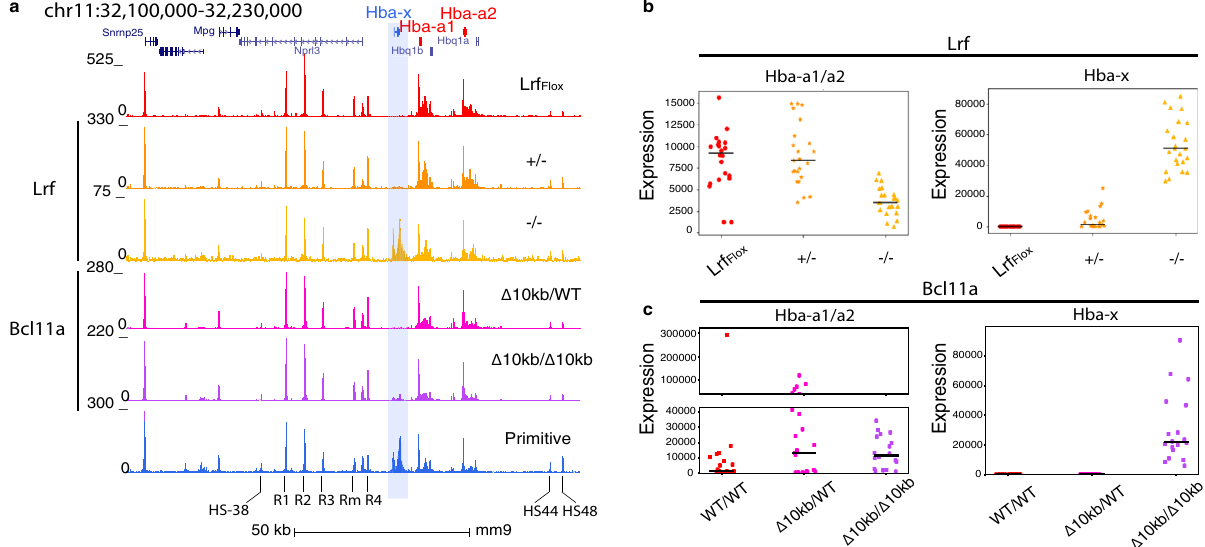
Fig. 6 Lrf and Bcl11a play a role in silencing ζ -globin expression in mice. a ATAC-seq at the α -globin locus in Lrf Flox / Lrf Flox ( Lrf Flox ), Lrf Flox/- ( + / − ), Lrf − / − ( − / − ) erythroid cells, Bcl11a Δ 10kb/WT ( Δ 10kb/WT) and Bcl11a Δ 10kb/ Δ 10kb ( Δ 10kb/ Δ 10kb) erythroid cells were taken at E12.5 – E13.5. The ζ -globin gene is highlighted in blue, tracks from de fi nitive and primitive erythroid cells (E12.5 and E10.5 respectively) are also shown. b , c Single-cell expression of α - and ζ - globin when Lrf and Bcl11a expression have been perturbed. Data are generated from littermates. Each dot represents a single cell, and the median expression is indicated by a horizontal